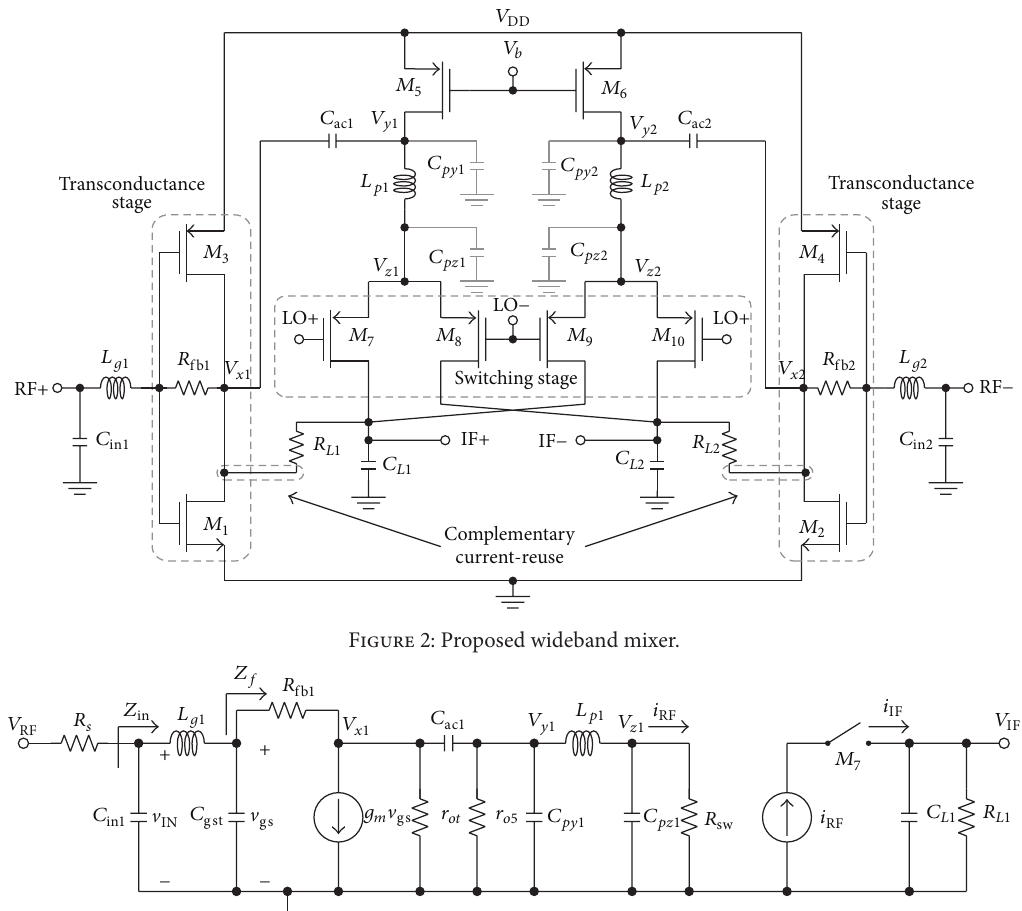
Figure 3: Half circuit small signal representation of the proposed wideband